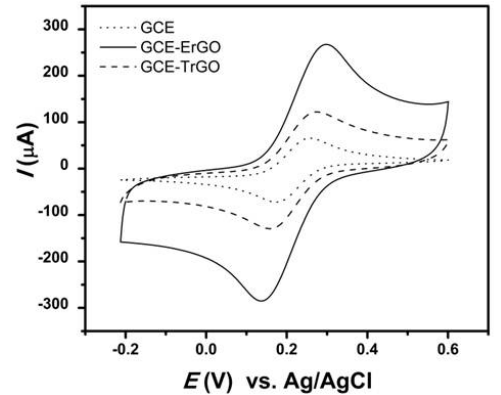
Figure 2. Cyclic voltammograms of GCE electrodes without modification, modified with TrGO (GCE-TrGO) and modified with ErGO (GCE-ErGO) in potassium ferrocyanide (5 mmol L -1